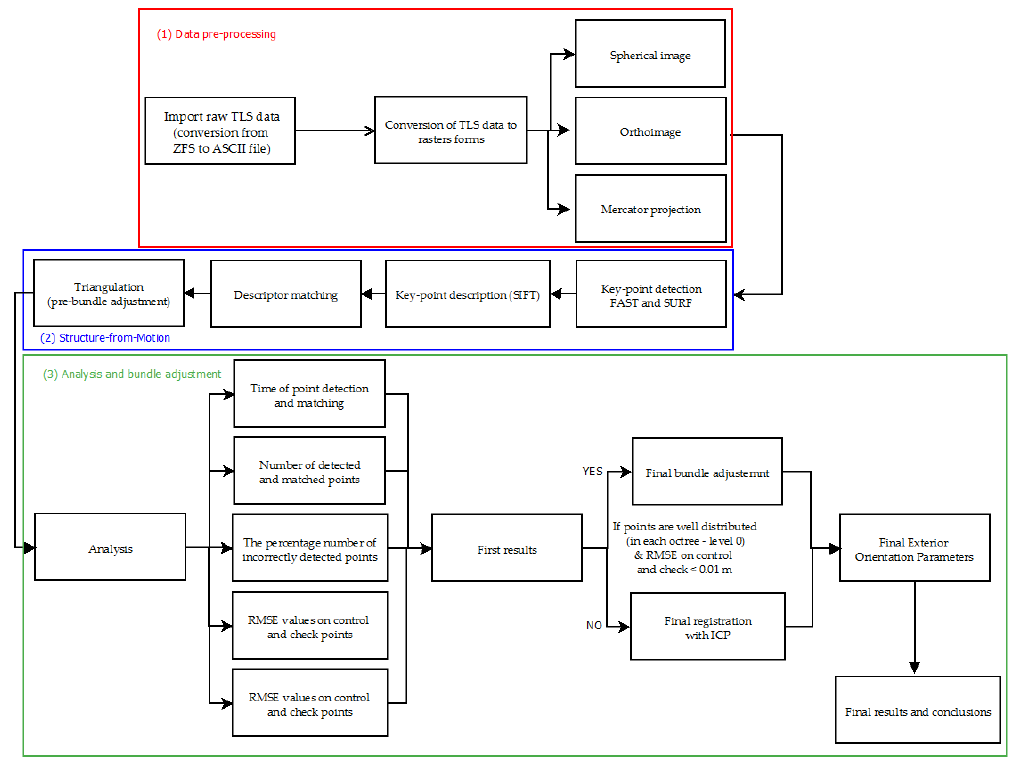
Figure 2. Diagram of the performed research: Processing and orientation of terrestrial laser scanning data based on the use of raster images in different cartographic projections of the intensity. TLS: Terrestrial Laser